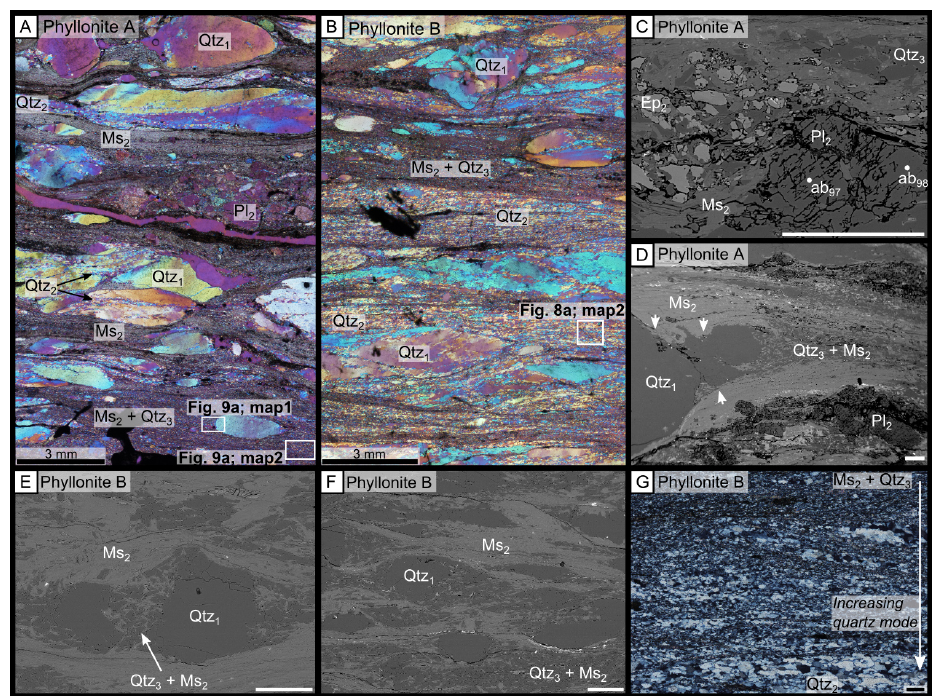
Figure 6. Typical microstructures and mineralogy in phyllonite A and B; scale bar for (b) – (g) is 200µm. (a) – (b) Optical micrographs (crossed polarizers with gypsum plate inserted), (c) – (f) BSE images and (g) optical micrograph with crossed polarizers; (a) overview of microstructures in phyllonite A; (b) overview of microstructures in phyllonite B; (c) fractured plagioclase grain surrounded by mantle of muscovite, epidote and quartz; (d) quartz grain having irregular boundaries with muscovite (noted with arrows) and mixed quartz–muscovite layer in the strain shadow; (e) the extensional site between two Qtz 1 grains filled by mixed quartz–muscovite aggregates; (f) Qtz 1 grains in muscovite–quartz matrix, showing the tendency of monomineralic muscovite layers to occur parallel to the shear direction and quartz– muscovite mixtures to occur in the strain shadows; (g) fine-grained matrix in phyllonite B showing variations of the quartz to muscovite modal amounts on the millimetre